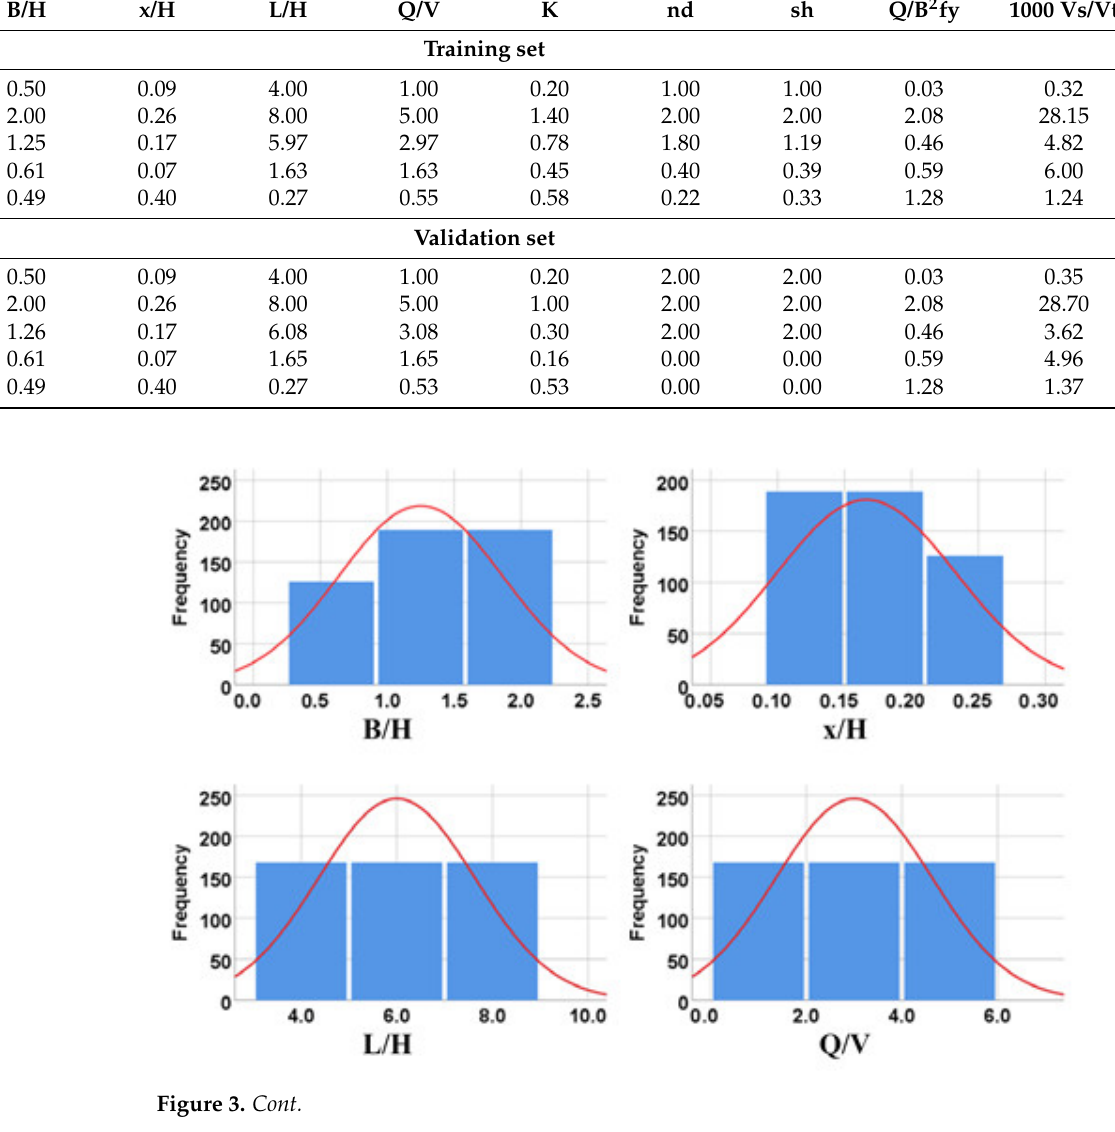
Figure 3. Distribution histograms for inputs (in blue) and outputs (in green).